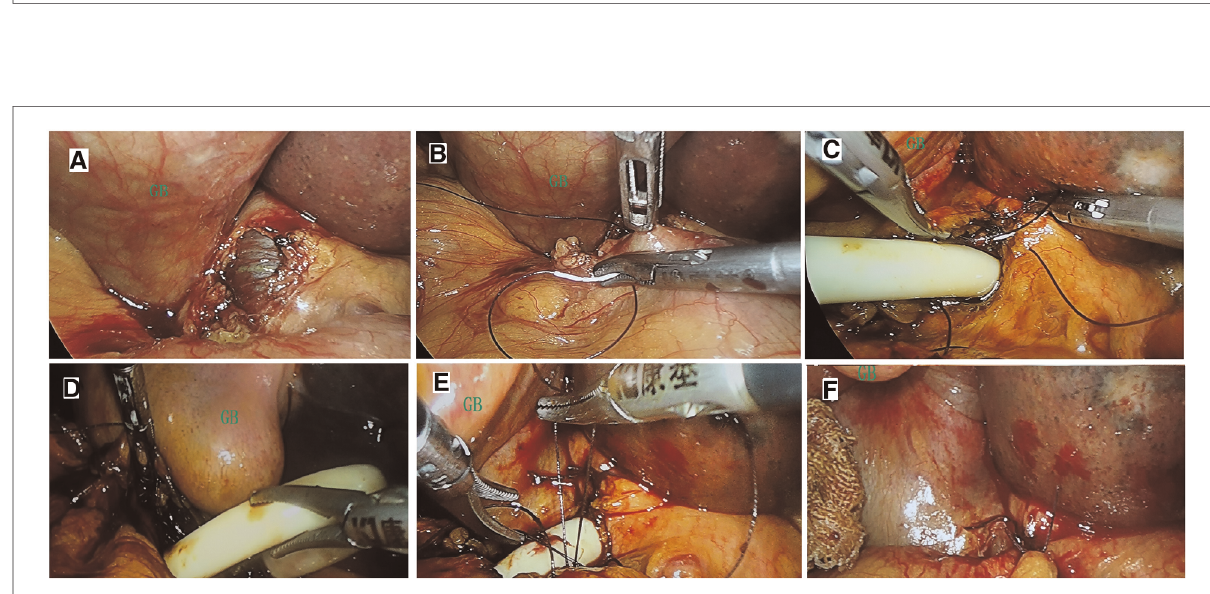
FIGURE 1 Positions of trocars and trimming of T-tube. Patients were placed in the supine position or slightly inclined to the left on the operation table. After general anesthesia and intubation, the operating area was then disinfected. A 10 mm incision was fi rst made at the right edge of the umbilicus and a 10 mm trocar was placed. Then, the laparoscope was placed after the pneumoperitoneum was constructed. Under the guidance of the laparoscope, two trocars for surgical instruments were placed below the xiphoid process (10 or 12 mm) and 2 cm below the costal margin of the right upper quadrant along the median line of the clavicle (5 mm), respectively ( A ). If assistance is required, a trocar (5 mm) can also be placed along the midline of the clavicle 2 cm below the costal margin of the right upper quadrant. The T-tube serves as a bridge for bile from the common bile duct into the duodenum, retaining a length of 10 – 12 cm to ensure that the distal T-tube of the duodenum can pass through the duodenal papilla ( B ).